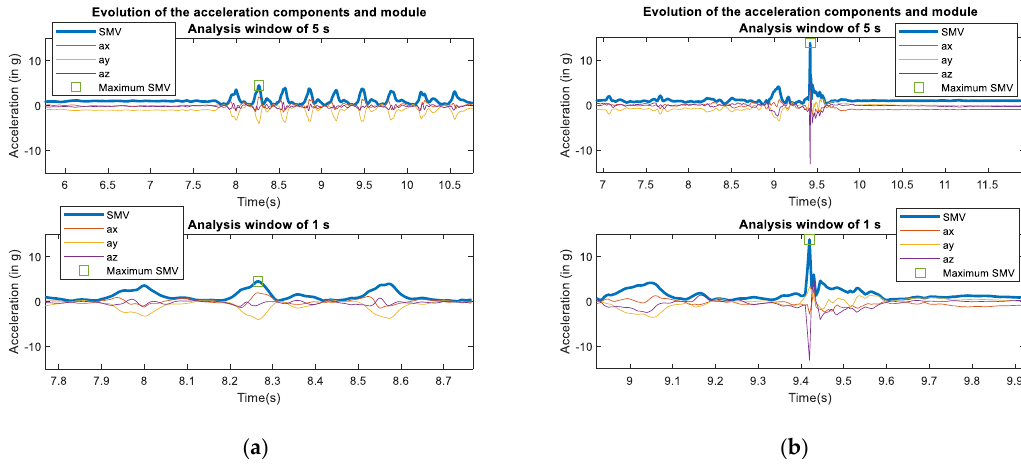
Figure 2. Detail of the progress of the acceleration components ( Ax, Ay, Az ) and magnitude (SMV) of the examples of Figure 1 for two different observation windows (±0.5 s and ±2.5 s) around the detected maximum of the SMV. ( a ) ADL; ( b ) Fall.